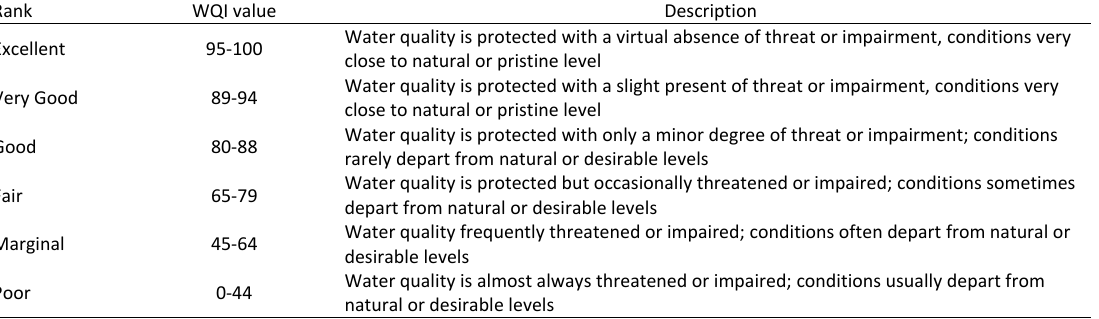
Table 2. Water quality objectives used in the model for aquatic ecosystem and recreational uses (CCME, 2001)